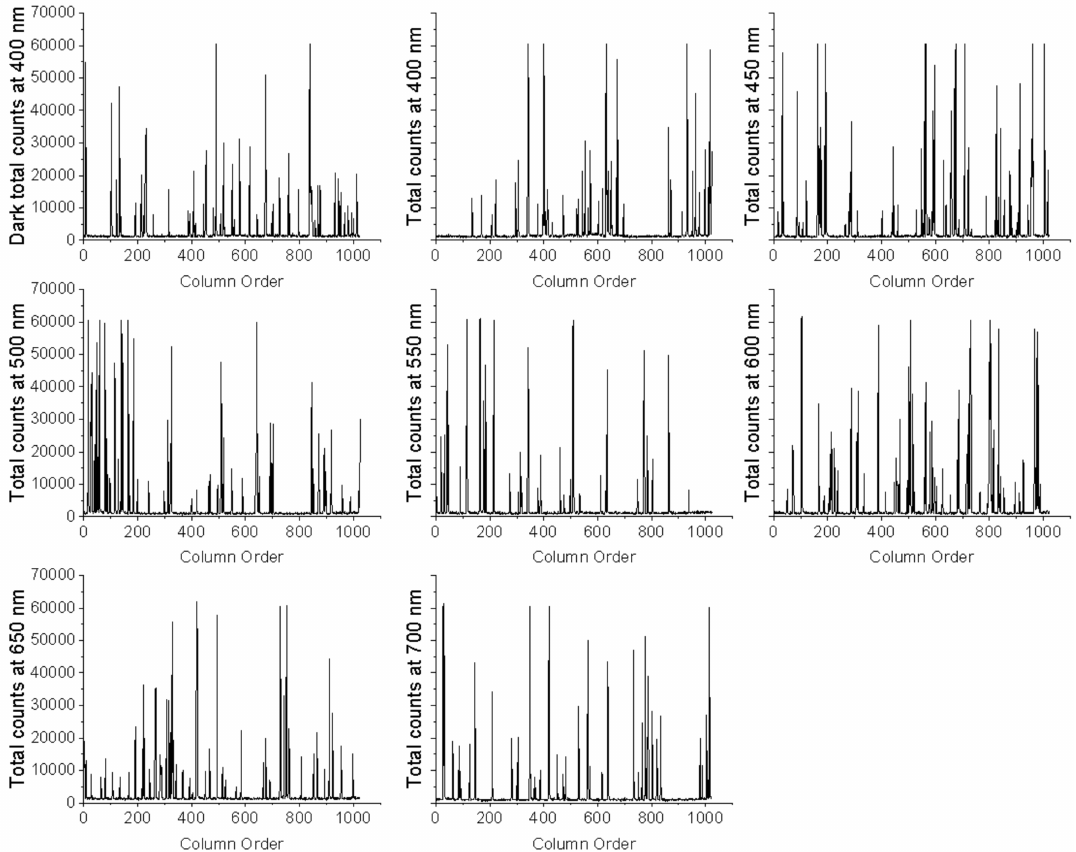
Figure 2. Examples of several FVB images (readings) obtained from the left hand of the subject at various